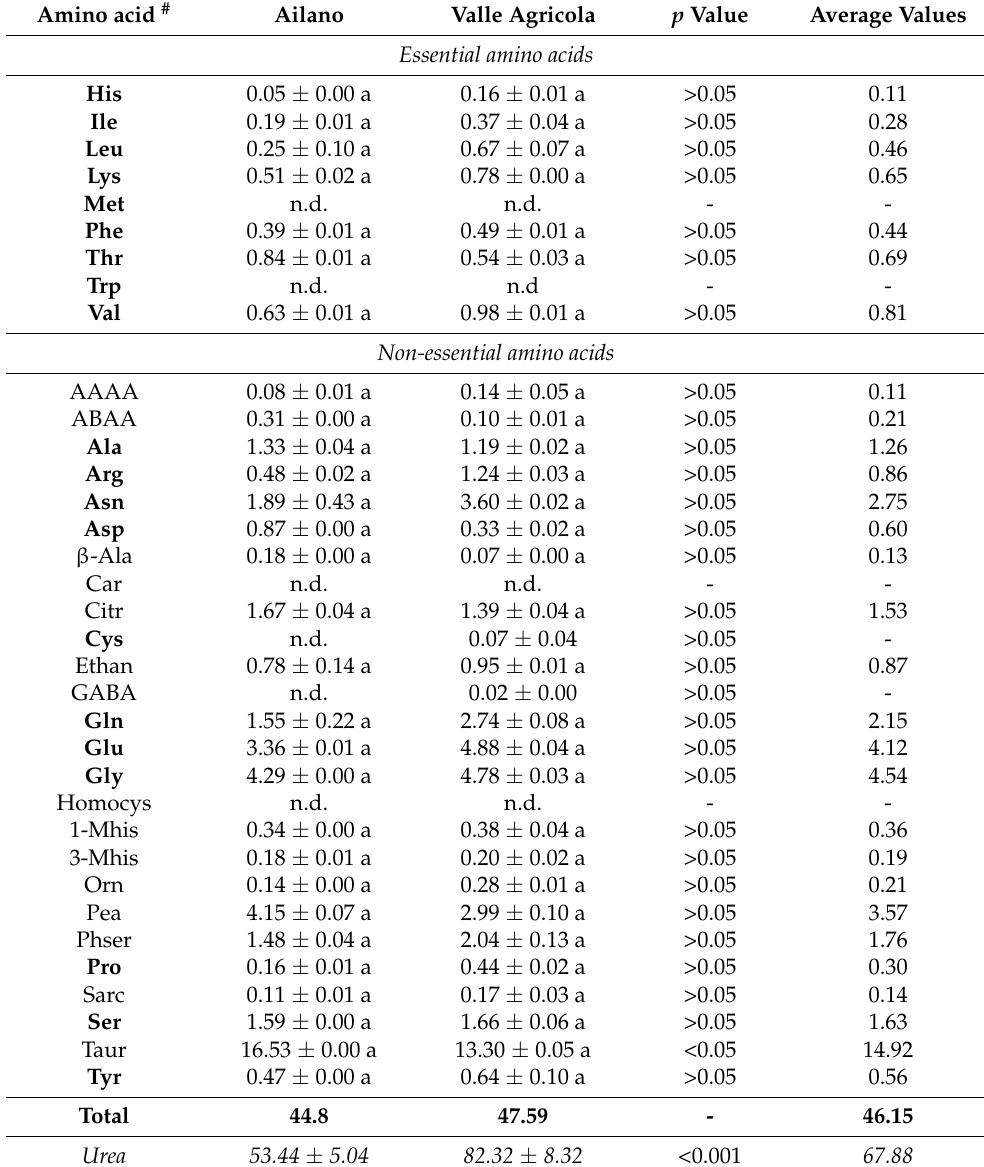
the analysis revealed that urea content in ‘Alto Casertano’ raw milk (67.88 mg/100 g of milk) represents about 22% of the NPN fraction from ‘Alto Casertano’ goat raw milk, while free amino acids represent about 15% of the NPN fraction. Table 6. Free amino acid composition of goat raw milk from ‘Ailano’ and ‘Valle Agricola’. Values are means ( ± SD) and are expressed as mg per 100 g of milk. See Section 2.2 of Materials and Methods section for more